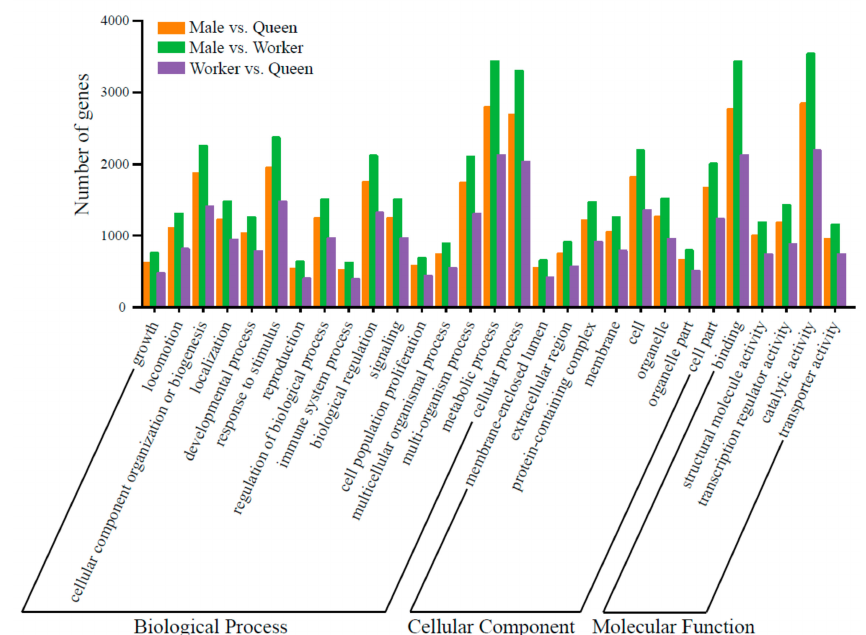
Figure 4. Gene Ontology (GO) enrichment analysis of potential target genes of the DE miRNAs of B. lantschouensis obtained in the male vs. queen, male vs. worker, and worker vs. queen comparisons. The x-axis shows the GO category, and the y-axis indicates the number of genes.